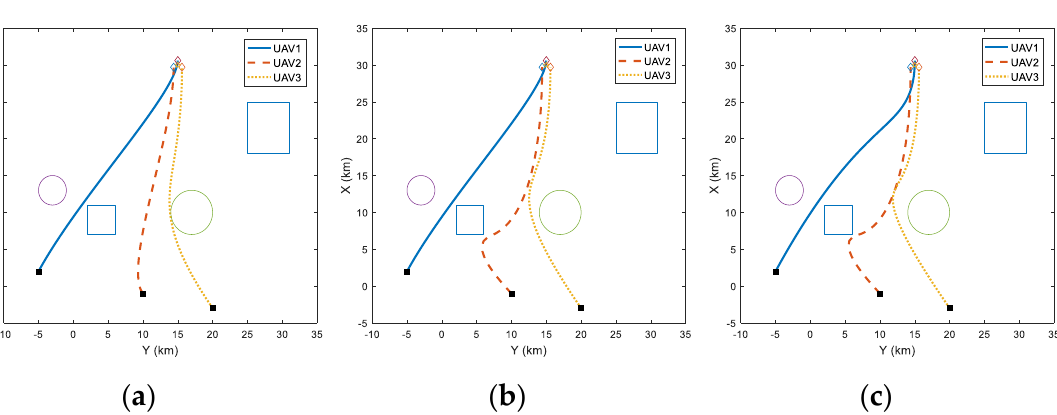
Figure 4. Paths of UAVs for formation rendezvous. (a) Produced by DCPSO without cooperation; (b) produced by DCPSO with cooperation; (c) produced by CCGA.